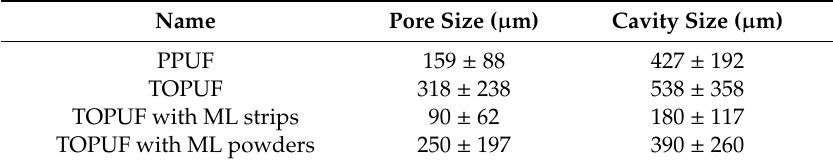
Figure 7. SEM images of PPUF ( a ), TOPUF ( b ), TOPUF with ML strips ( c ) and powders ( d ). Table 3. Sizes of pores and cavities in different polyurethane foam (PUF).